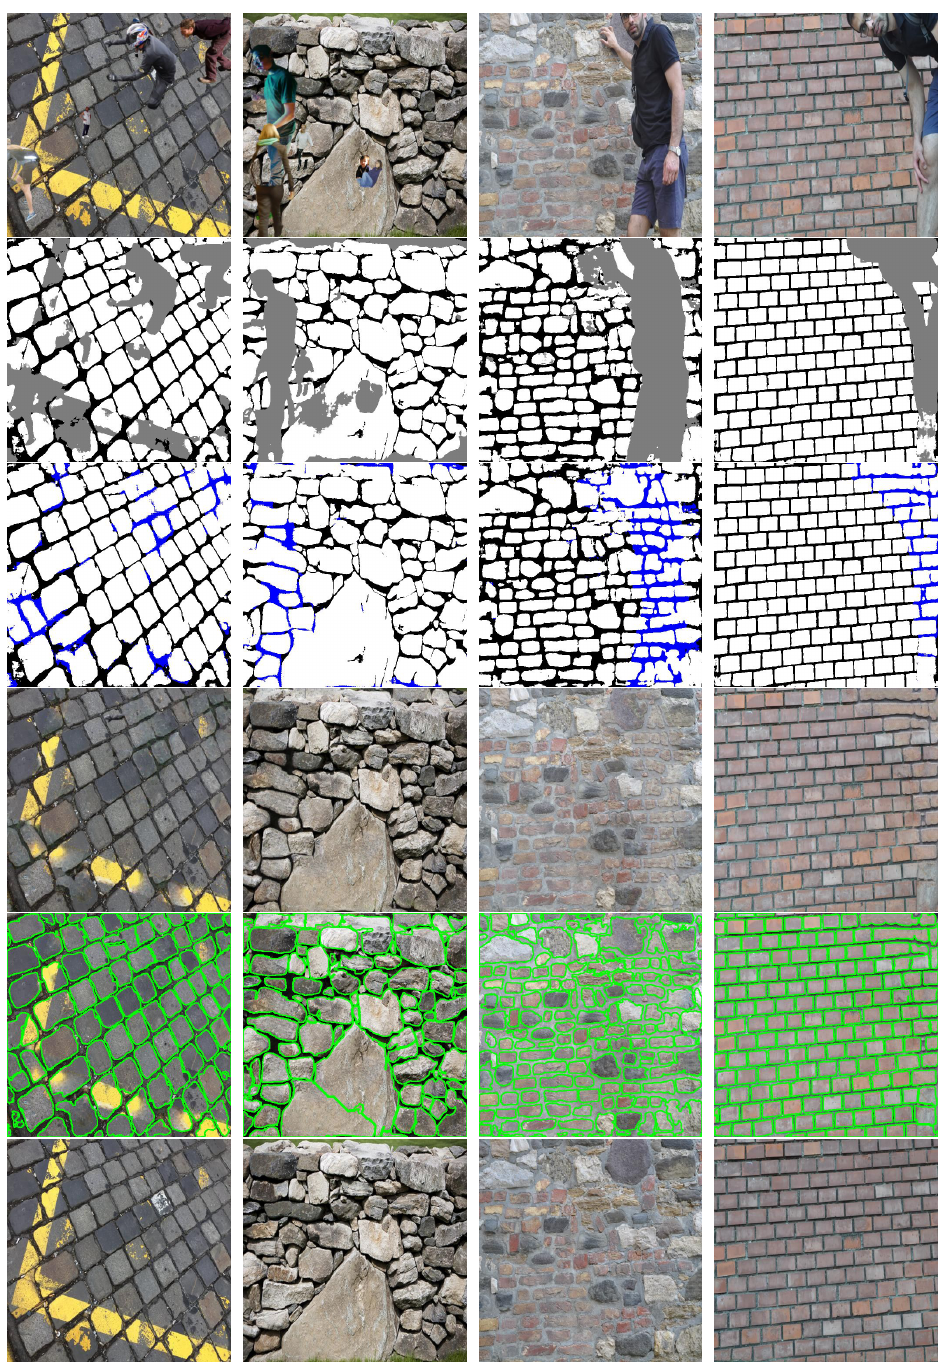
Figure 15. Results of the proposed algorithm step by step for four samples in the test dataset, first row: input images with occluding objects (first two images: synthetic occlusions, last two images: real occlusions), second row: U-net output, third row: I G1_out output, fourth row: segmentation output, fifth row: GT. In the first example (see the first column), the pre-processing step predicts some segments of the yellow line as occluding objects, due to their outlier color values compared to other segments of the wall. The false positive occlusion predictions naturally affect the final results, however, as shown by